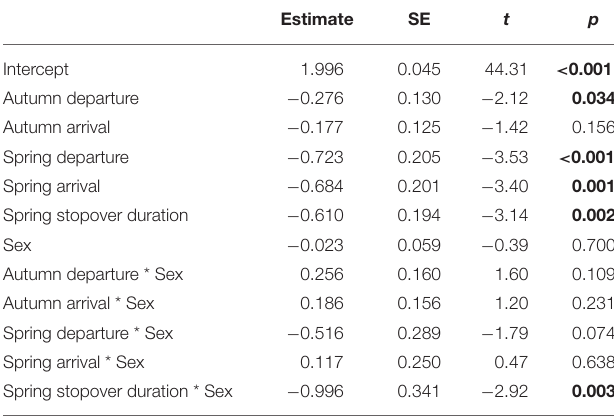
TABLE 3 | Results of the general linear model testing the effects of stage and sex on absolute interannual differences; estimates for stages are in relation to laying and for sex it is of male in relation to